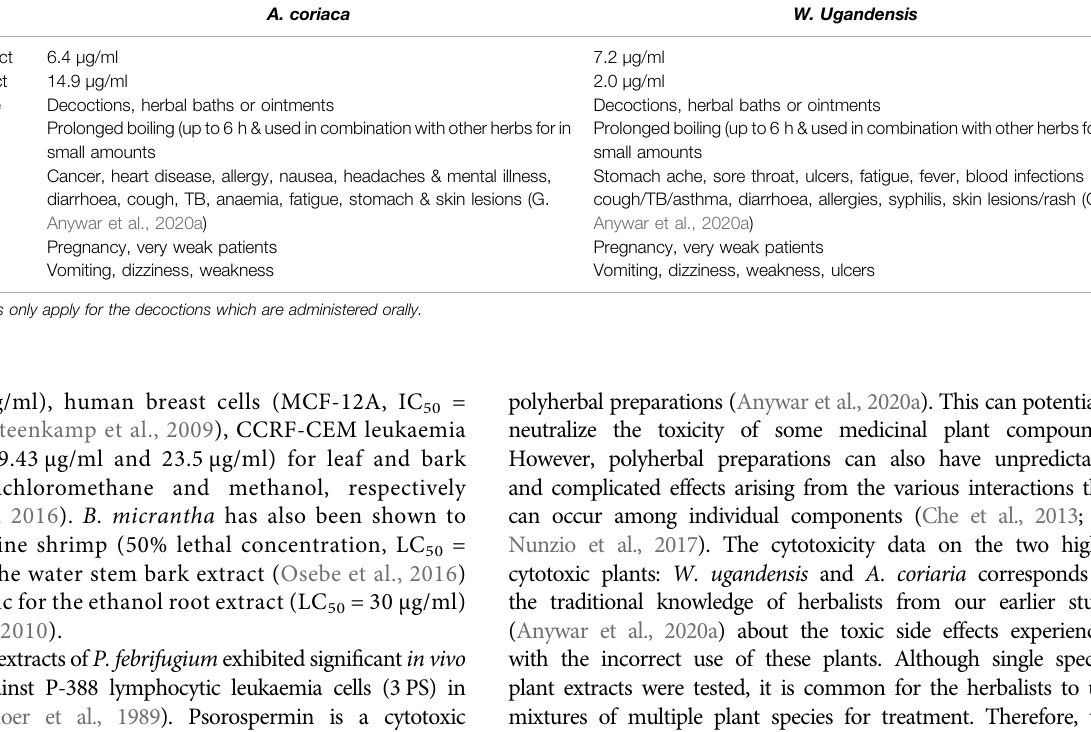
TABLE 2 | A comparison of cytotoxicity and medical indication, use and traditional knowledge on toxicity of A. coriaca and W. ugandensis Additional